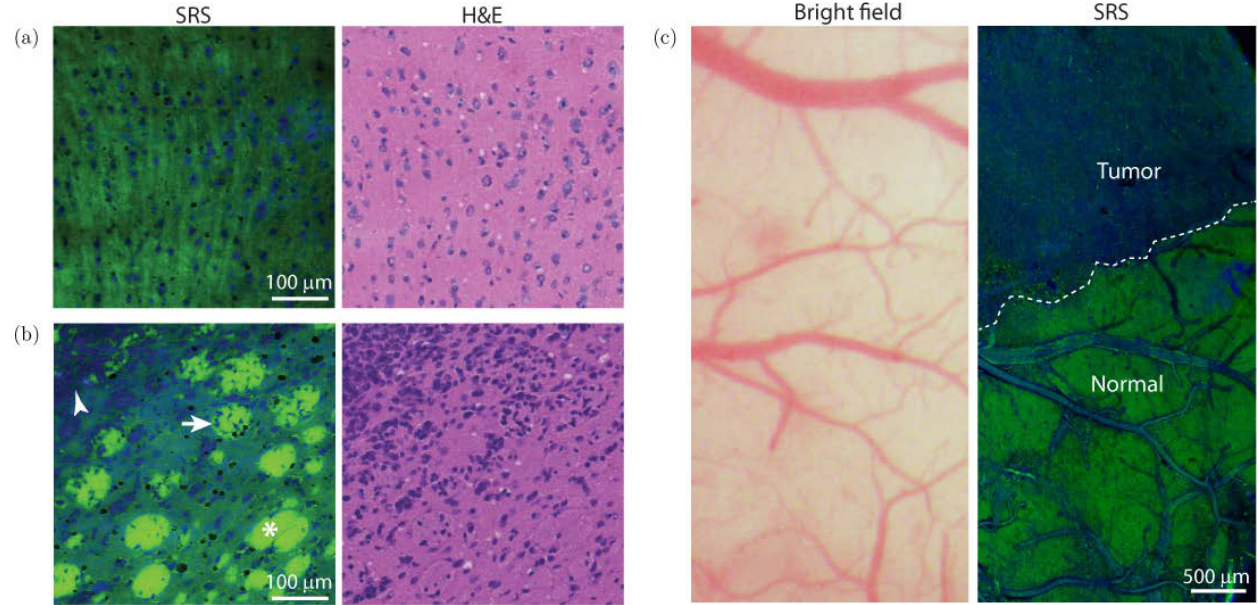
Fig. 3. Two-color SRS images of human GBM xenograft mouse brains: (a) SRS and H&E images of a normal brain frozen section, (b) SRS and H&E images of a GBM in¯ltrated brain frozen section and (c) in the ¯eld of view where bright ¯eld microscope appears grossly normal, SRS image shows a distinct margin between tumor and normal